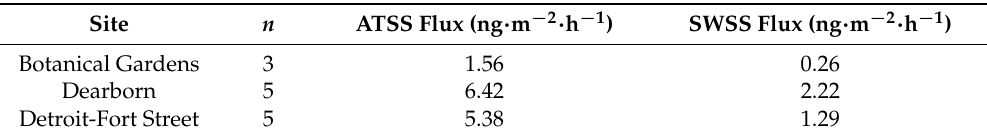
Table 3. Comparison of Artificial Turf Surrogate Surface (ATSS) versus Static Water Surrogate Surface (SWSS) sampler at Michigan